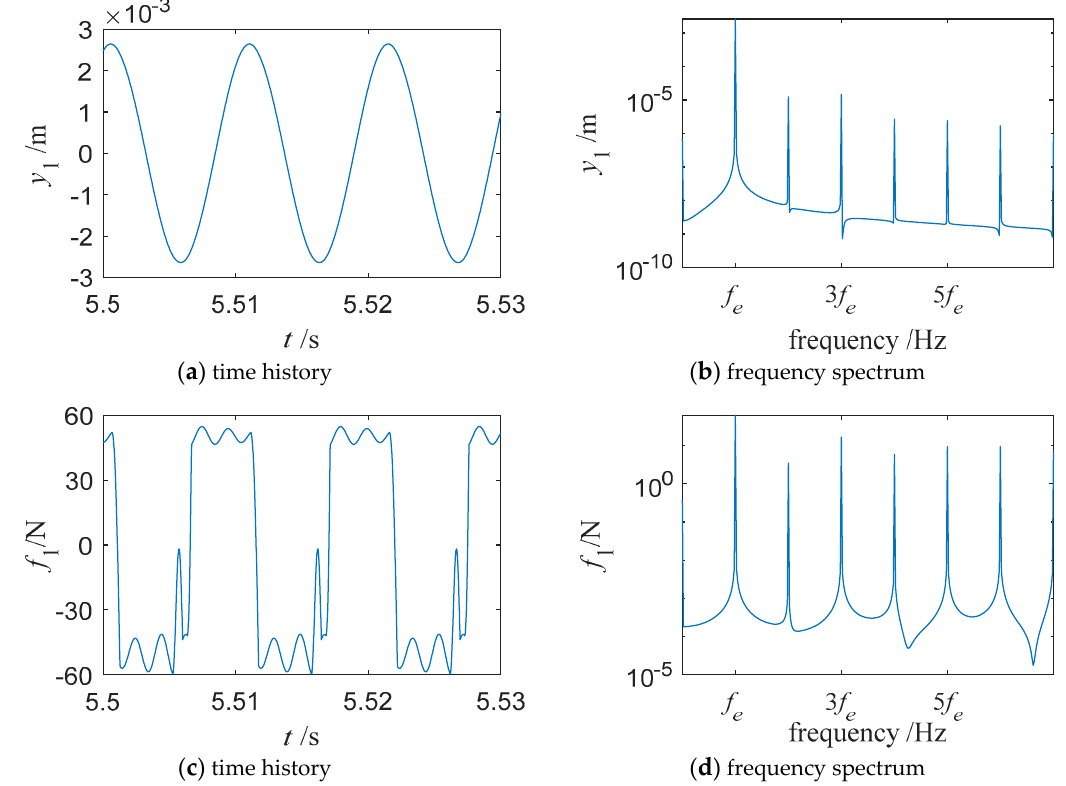
Figure 8. Steady-state dynamic characteristics of the response ( a , b ) and dry friction force ( c , d ).